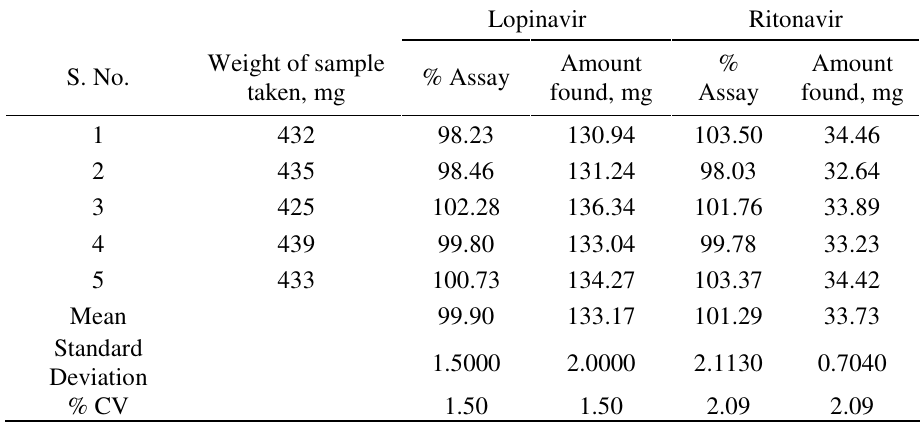
Table 2. Results of HPTLC Assay Studies (from pharmaceutical preparations) (n=5)